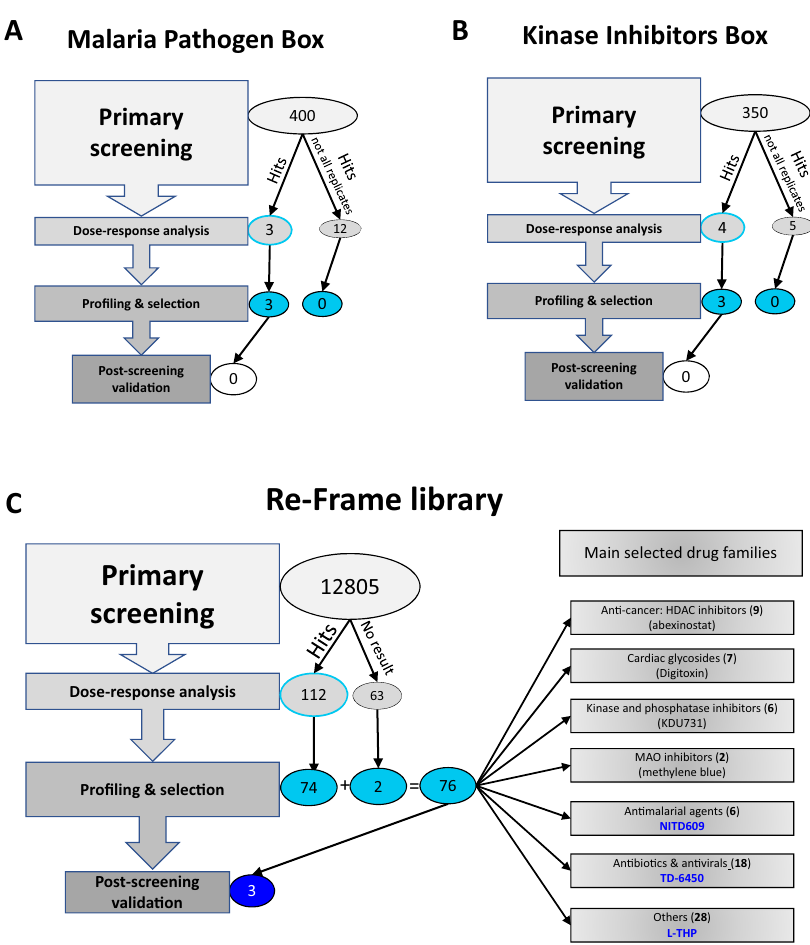
Fig. 1 | High-throughput screening based on mitochondrial staining and cell deformability identi fi es compounds with both killing effect and stiffening activity on P. falciparum late gametocytes. Screening progression cascade of three different libraries: Malaria Pathogen Box ( A ), Kinase Inhibitors Box ( B ), and ReFrame library ( C ). A 3 hits from primary screening were submitted to dose- response analysis along with 12 compounds found active in some but not all screening replicates. The 3 hits were con fi rmed but none of them was selected for further post-screening validation. B Four hits from primary screening along with 5 compoundsfoundactiveinsomebutnotallscreeningreplicatesweresubmittedto dose-response analysis raising 3 con fi rmed hits. None of them was selected